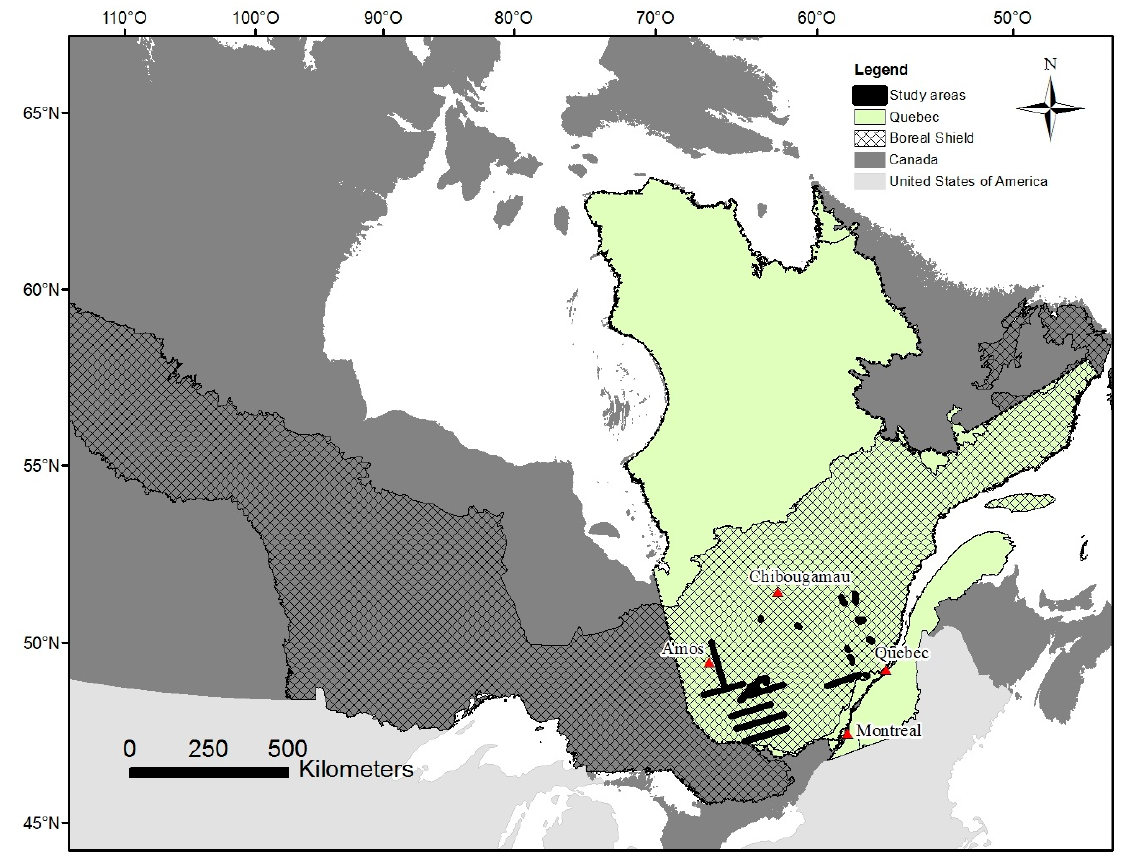
Figure 1. Location of study sites in Quebec, Canada.